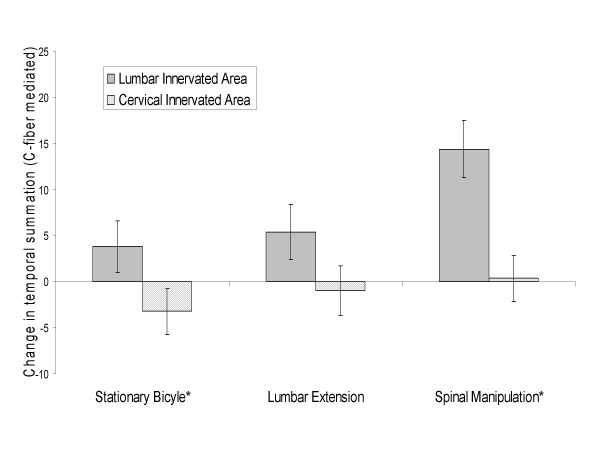
Temporal summation hypoalgesia for stationary bicycle, lumbar extension, and spinal manipulation. Figure 2 Key • Positive numbers indicate hypoalgesia • Error bars are 1 standard error • * – indicates statistically significant (p < 0.05) difference in intervention for pain sensitivity in lower extremity area.